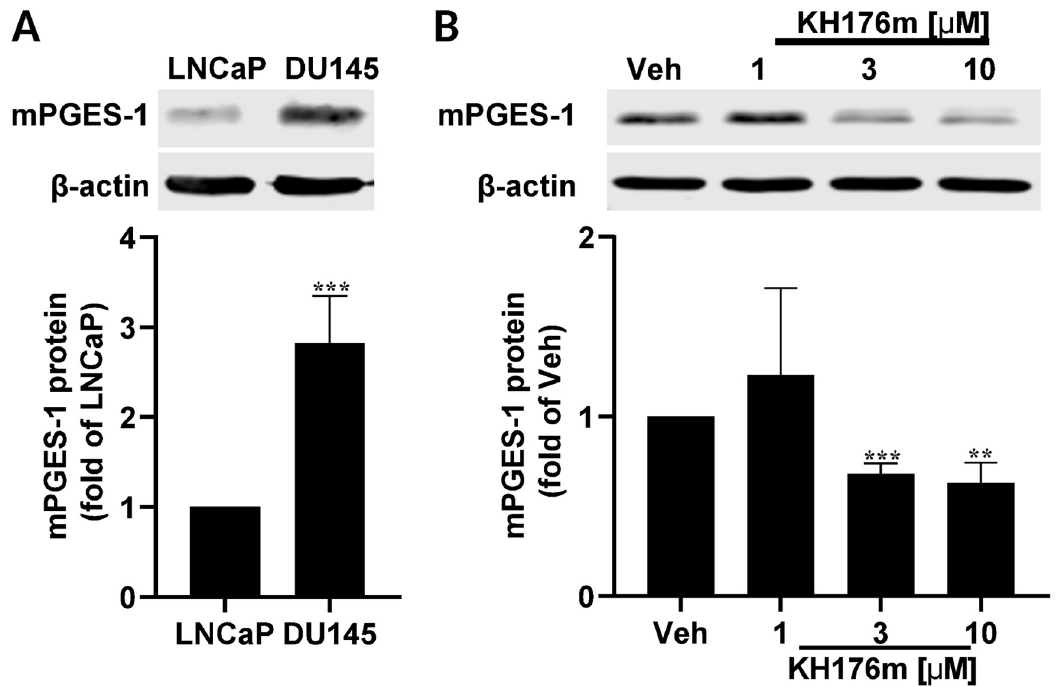
Fig 1. Constitutive expression of mPGES-1 in DU145 PCa cells is reduced by KH176m. Human prostate cancer cells (DU145 and LNCaP) were grown in monolayer cultures. Protein was isolated and separated by SDS-PAGE and expression of mPGES-1 was analyzed by western blot. (A) DU145 cells have higher levels of mPGES-1 protein as compared to LNCaP cells (n = 3). (B) mPGES-1 expression is reduced in DU145 cells treated with increasing concentrations of KH176m for 24 h as compared to vehicle treatment (0.1% DMSO) (n = 3). �� , p < 0 . 005 ; ��� , p < 0 . 001 ; significant differences compared with the LNCaP or